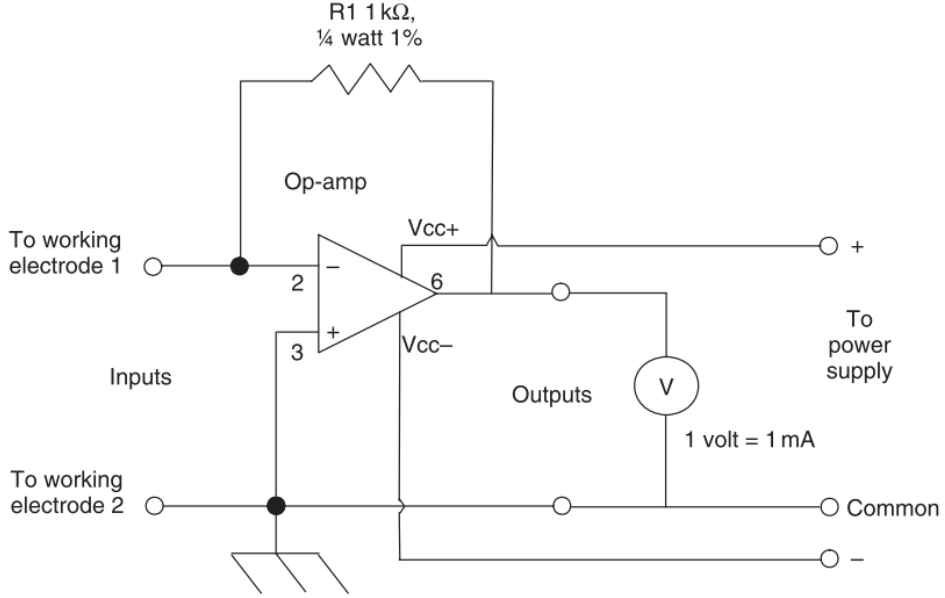
Figure 19. A common circuit for a zero-resistance ammeter (Reprinted with permission from ref. [73]. Copyright 2008 Elsevier).